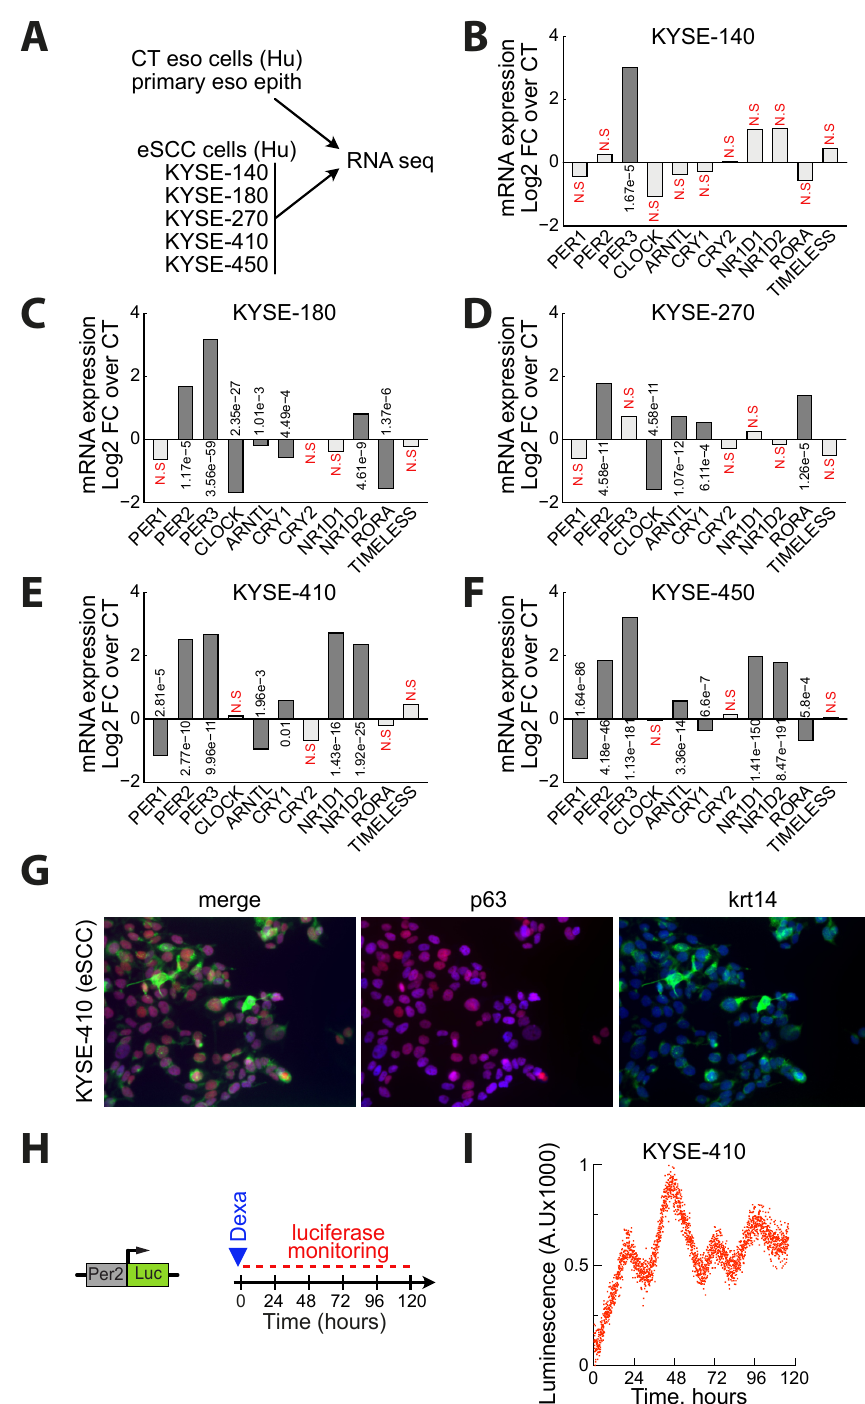
Figure 2. PER2 expression oscillates in human eSCC cells in spite of alterations in the pattern of clock-related gene expression. ( A ) Experimental design. ( B ) Histogram depicting the expression of clock related genes measured by RNA sequencing in the KYSE-140 human eSCC cell line. Data are represented as the mean of a biological duplicate. FDR is indicated for each gene. Benjamini–Hochberg method on the p -values was used to control the false discovery rate (FDR). ( C ) Same as in (B) in the KYSE-180 human eSCC cell line. ( D ) Same as in ( B ) in the KYSE-270 human eSCC cell line. ( E ) Same as in (B) in the KYSE-410 human eSCC cell line. ( F ) Same as in (B) in the KYSE-450 human eSCC cell line. ( G ) Co-immunostaining of p63 and Krt14 in the KYSE-410 human eSCC cell line. ( H ) Experimental design to monitor the activity of the PER2 promotor in KYSE-410 cells. ( I ) Real time monitoring of luciferase activity in the KYSE-410 human eSCC cell line. FDR>5% are considered non-significant